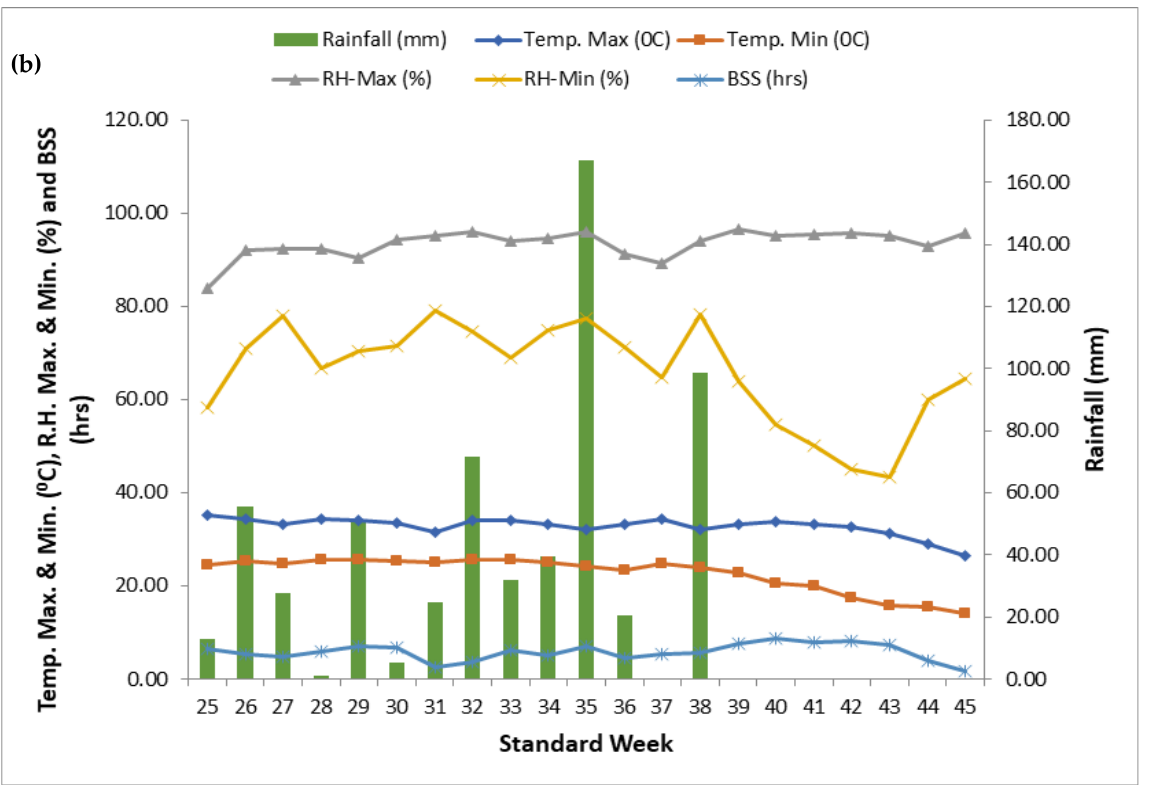
Figure 1. Mean weekly agro-meteorological data during the crop growing kharif season: ( a ) 2016 and ( b ) 2017.